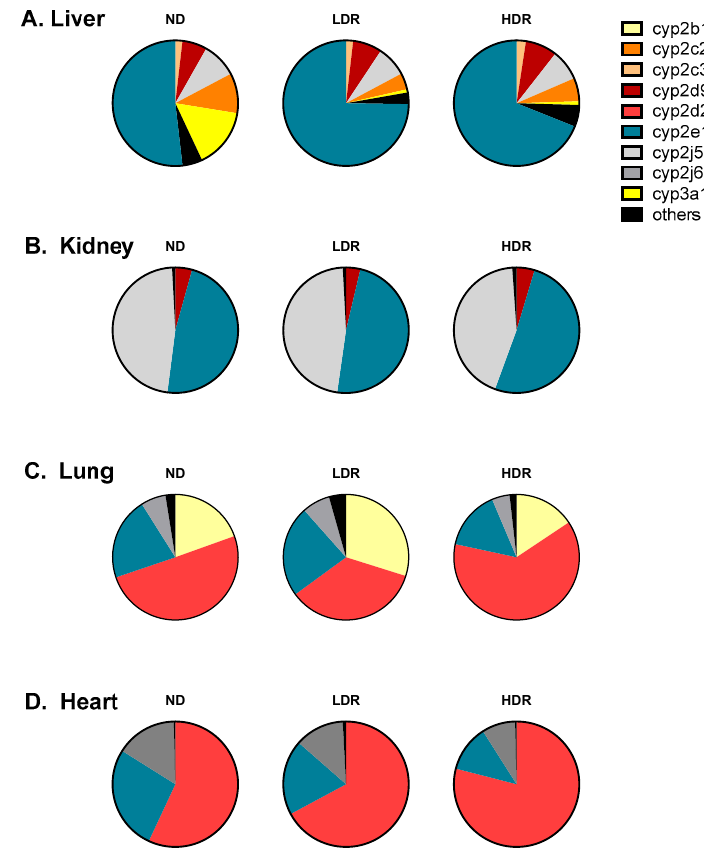
Figure 1. Cyp450 mRNA pie charts. Total mRNA transcripts for each isoenzyme are displayed as expressed in C57BL6 mouse microsomes according to diet group: ( A ) Liver; ( B ) Kidney; ( C ) Lung; and ( D ) Heart. ND, Normal diet; LDR, low-diet responders; and HDR, high-diet responders. Cyp450